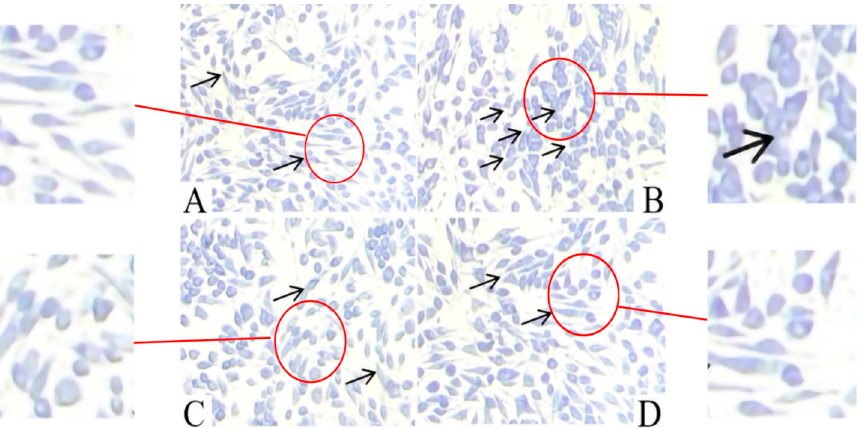
Figure 2. Effect of AT on release of granules by C48/80-stimulated RBL-2H3 cells. ( A ). Normal RBL-2H3 cells; ( B ). C48/80-stimulated RBL-2H3 cells; ( C , D ). Effect of treatment with AT (between 30 and 60 μ M) C48/80-stimulated RBL-2H3 cells, n = 3.